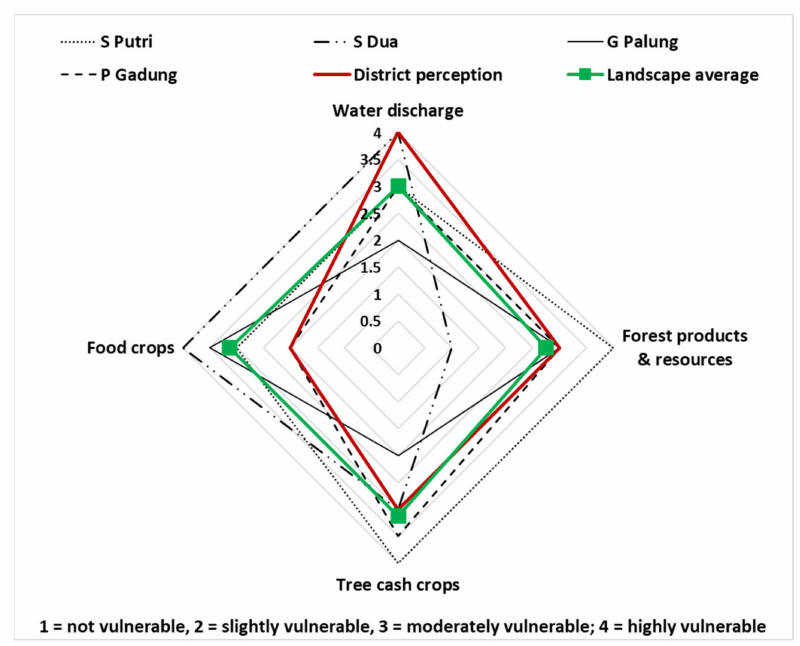
Figure 7. Perceived vulnerability scores of the communities in Ketapang as perceived by FGDs in four landscapes and by district stakeholders (S Putri = Sungai Putri; S Dua = Simpang Dua; G Palung = Gunung Palung; P Gadung = Pematang